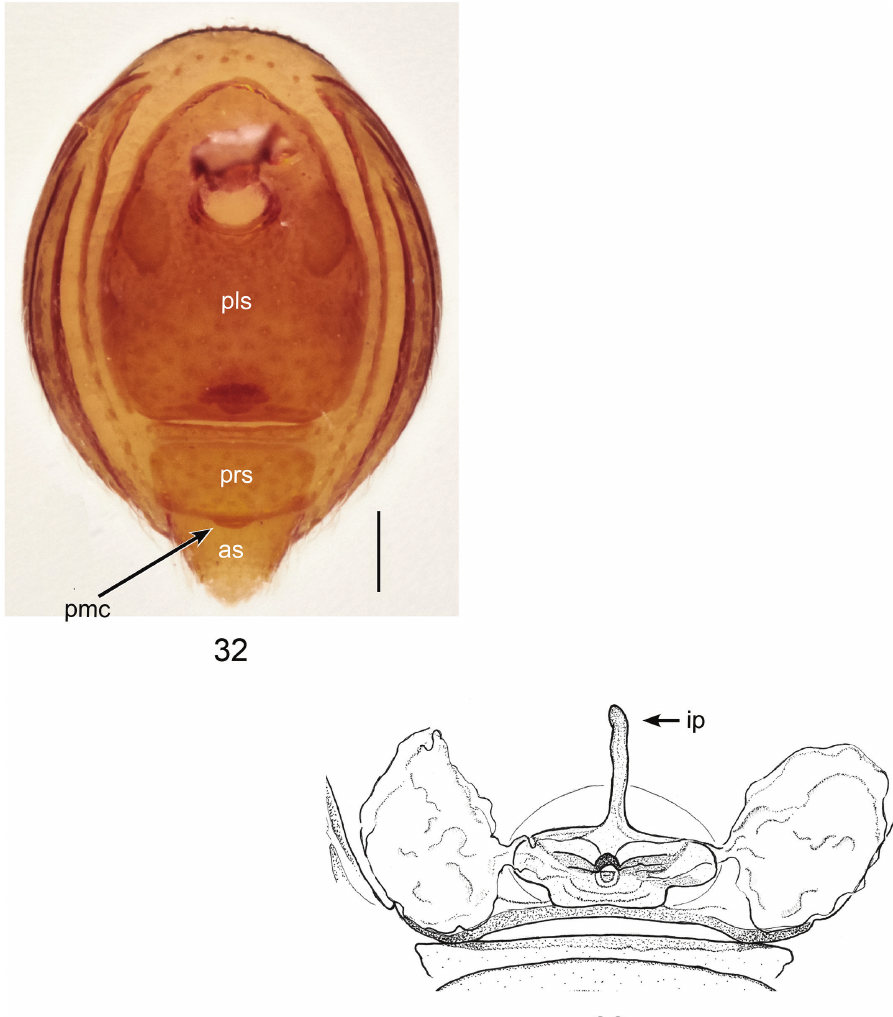
Figures 32, 33. Ablemma singalang Lehtinen, 1981, female. 32 Abdomen, ventral view. 33 Schematic illustration of genitalia, dorsal view. Scale bar: 0.1